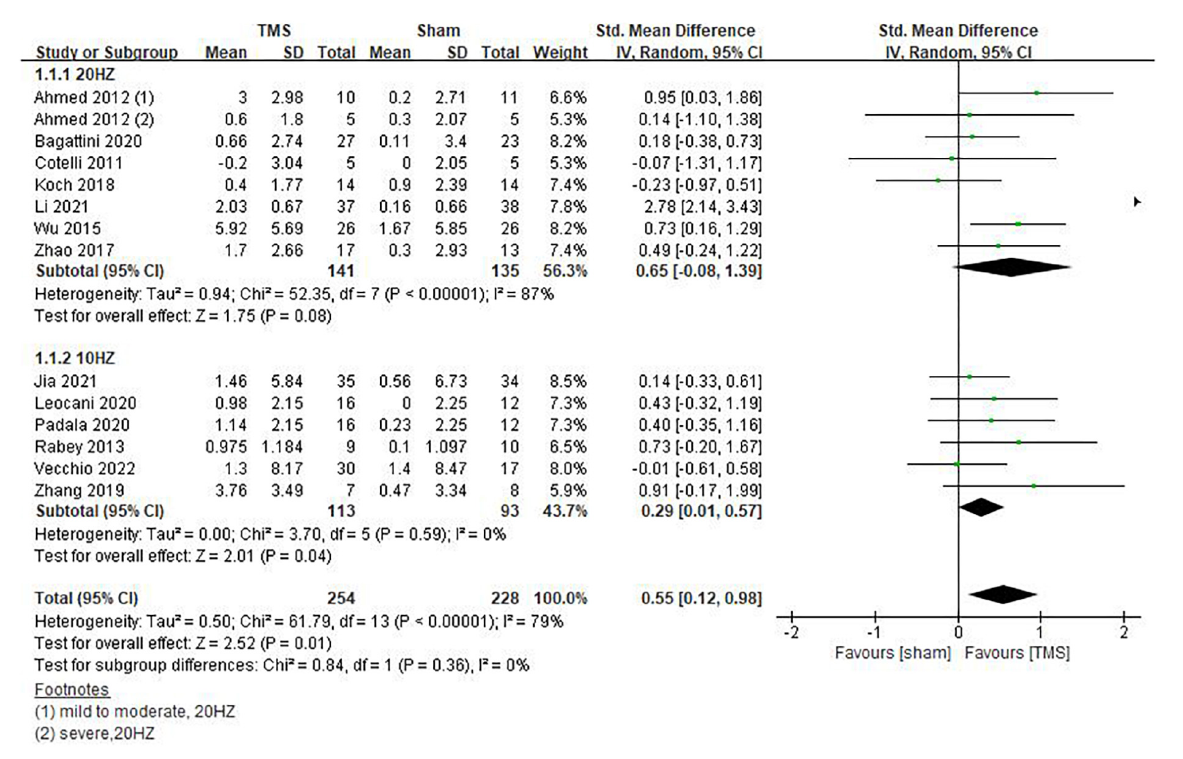
FIGURE4 Impact of repetitive transcranial magnetic stimulation (rTMS) stimulation frequency on global cognitive